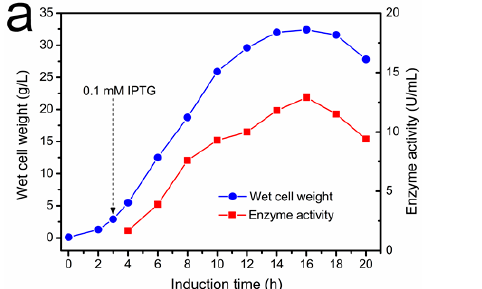
Figure 3. Expression of recombinant I303V MAT in a 10-L bioreactor. ( a ) Effect of induction time on cell biomass (g wet cell weight/L) and the activity of recombinant I303V MAT. The recombinant E. coli cells were induced by the addition of IPTG (isopropyl β - D -1-thiogalactopyranoside) to a final concentration of 0.1 mM; ( b ) SDS-PAGE (10%) analysis of the expression of the recombinant I303V MAT. Lane M: Molecular weight marker. Lane 1: Total protein of recombinant E. coli before IPTG induction. Lanes 2–5: Total protein of recombinant E. coli induced with IPTG after 5, 9, 13, and 17 h, respectively.